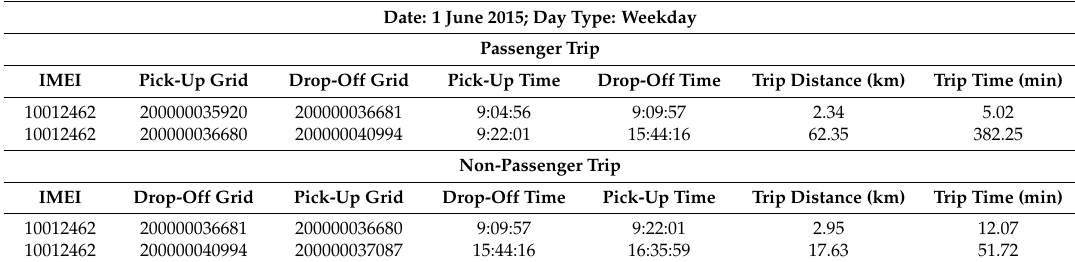
Table 2. Passenger and non-passenger